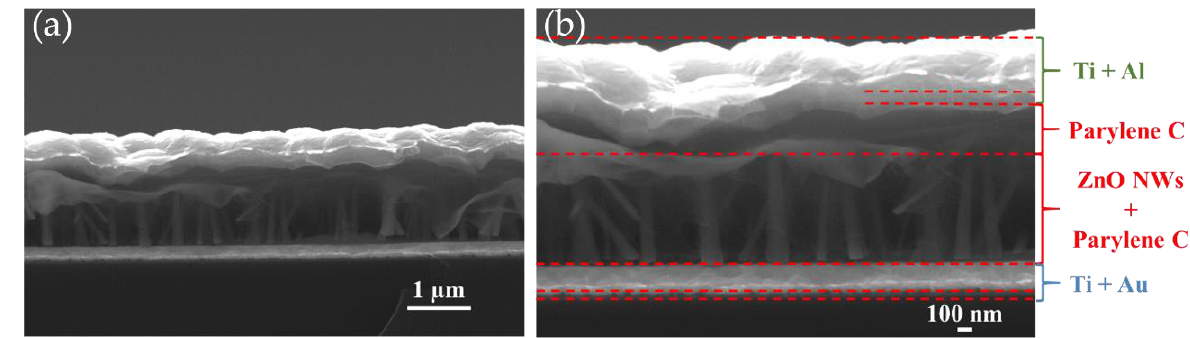
Figure 3 . Cross-sectional SEM images of PENG at ( a ) 15,000× and ( b ) 30,000× magnifications.